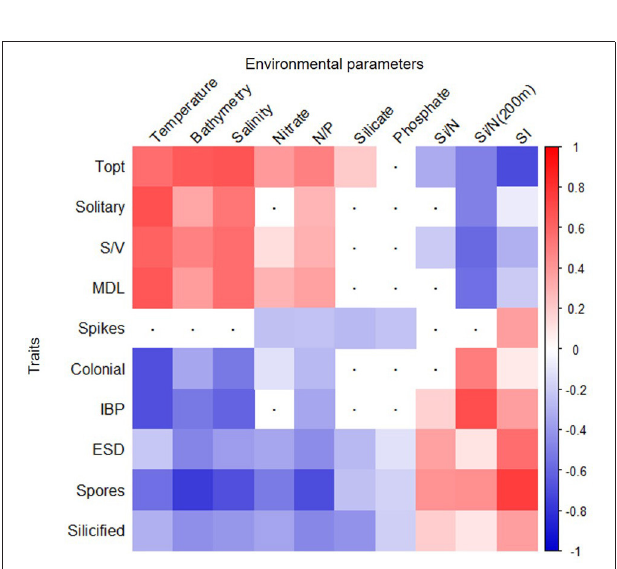
FIGURE 7 | Spearman correlation plot of environmental factors and diatom species traits. Statistically significant ( p < 0.005) positive (red) and negative (blue) correlations are shown for each combination. White squares with black dots refer to non-statistically significant relationships. Trait abbreviations are explained in Figure 3 . Environmental abbreviations refer to Stratification Index (SI) nitrate to phosphate (N/P) and silicate to nitrate concentrations ratio at the surface (Si/N) or at 200m (Si/N